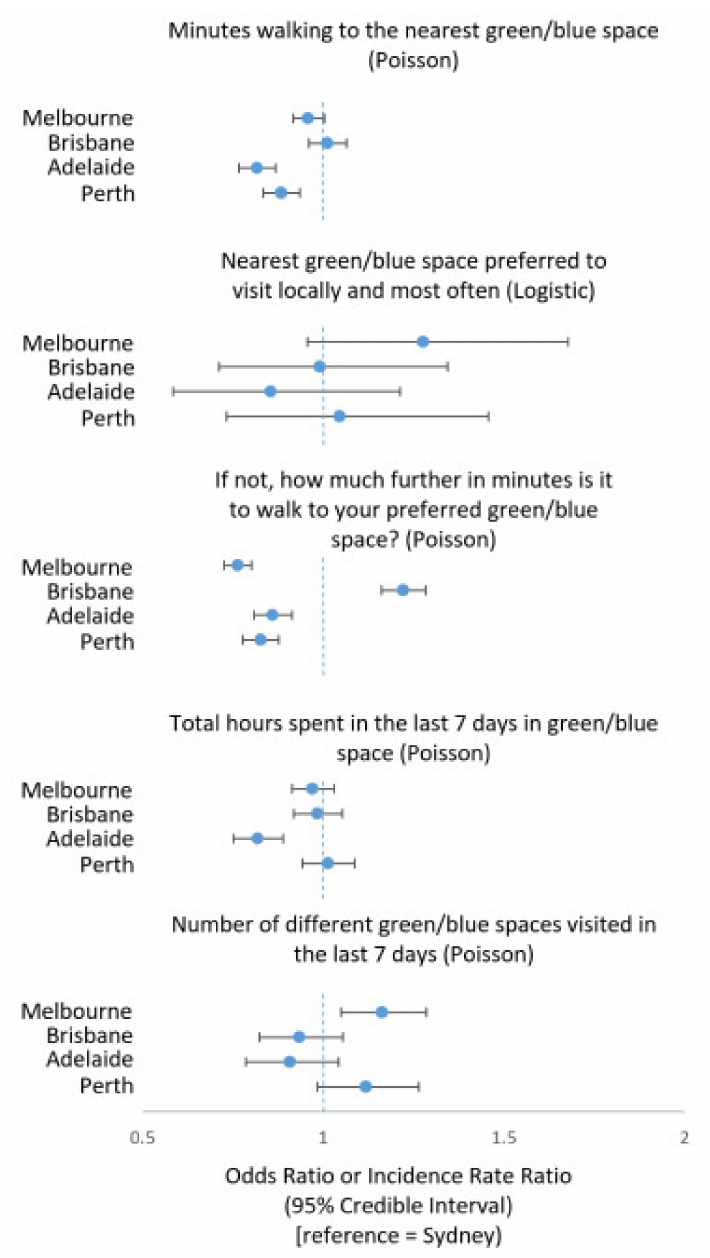
Figure 3. Differences between Australia’s most populous cities in access to and visitation of the nearest and preferred green or blue spaces during the COVID-19 pandemic (multilevel Poisson and logistic